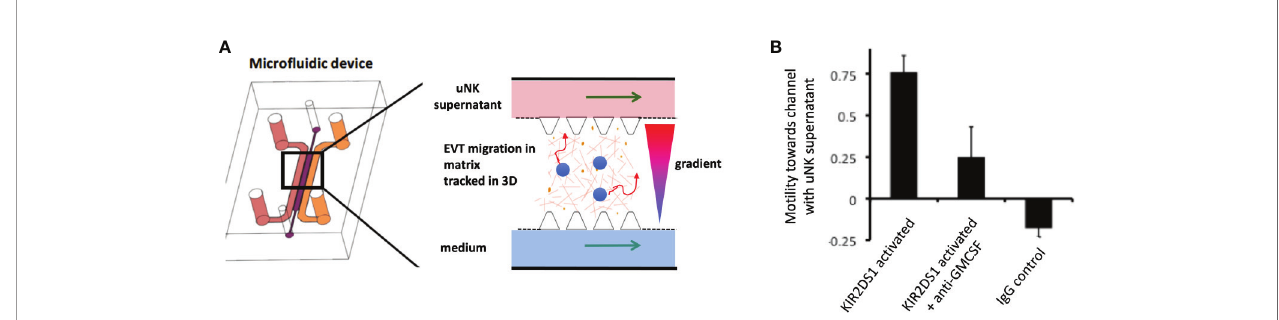
FIGURE 8 | Ligation of activating KIR on uNK affects human trophoblast migration in vitro. (A) Cartoon showing a cross section of a micro fl uidics device to study effects of uNK supernatants on migration of extravillous trophoblast (EVT) . Primary human EVT isolated from fi rst trimester placentas are stained with tracker dye (blue) and embedded in Matrigel in the central channel. Cells are tracked in real time as they move between two side channels. These side channels have medium constantly fl owing through them and can be supplemented with other factors or supernatants conditioned by uNK cells to create a gradient. (B) Plot showing motility of EVT towards or away from a microchannel containing uNK-conditioned medium. Freshly isolated uNK were puri fi ed from decidua using microbeads and KIR2DS1 was activated by EB6 antibody cross-linking for 12 hours. Stimulation conditions are shown on x-axis. On average, EVT display increased motility towards a channel containing supernatant from uNK stimulated by KIR2DS1 cross-linking. This is reduced by the addition of neutralising anti-GM-CSF in the supernatant. Control is ligation with isotype matched irrelevant IgG. Motility is calculated by subtracting the number of cells migrating upstream towards the uNK supernatant channel by the number of cells migrating away and dividing this by the total number of cells, [Figure adapted from Abbas et al.